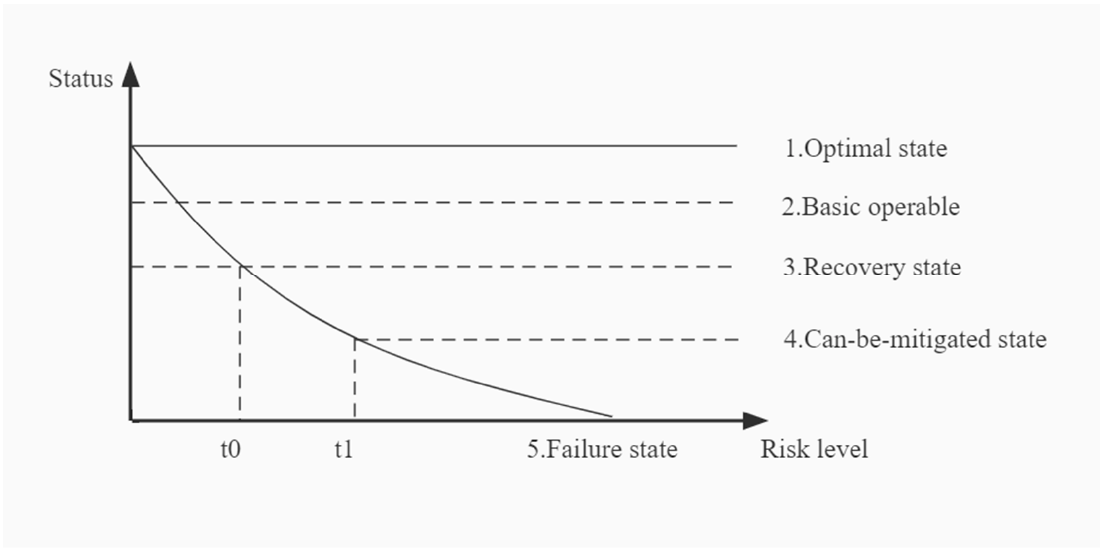
Figure 7. The five key states of accident risk occurrence.